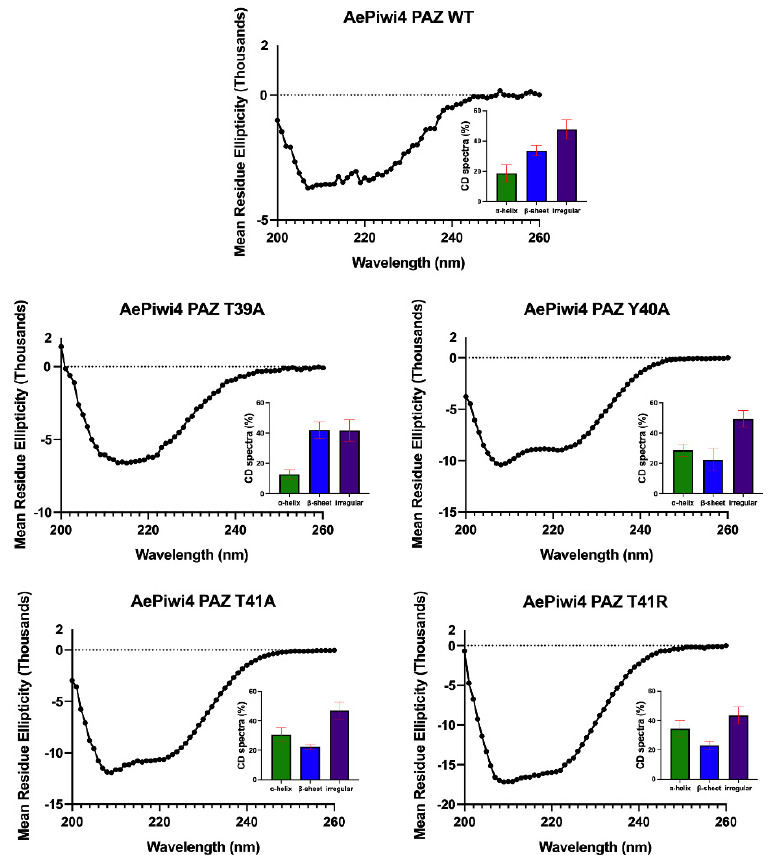
Figure 4. Circular dichroism (CD) spectra analyses of AePiwi4 PAZ mutants. CD spectra curves, by mean residue ellipticity for AePiwi4 PAZ WT and mutant proteins, recorded over 200–260 nm. Insets show the calculated percentages of secondary structures determined by CD analysis using CAPITO. Red bars indicate mean and standard deviation of three similarity hits based on lowest area differences under the curve.